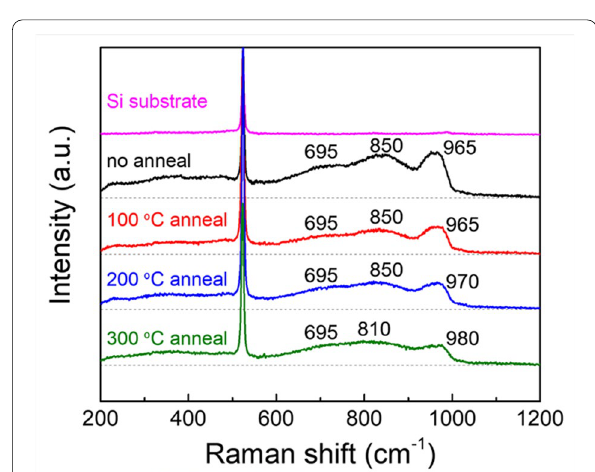
Fig. 2 The UV Raman (325 nm) spectra of post-annealed 20-nm-thick MoO X films on polished silicon